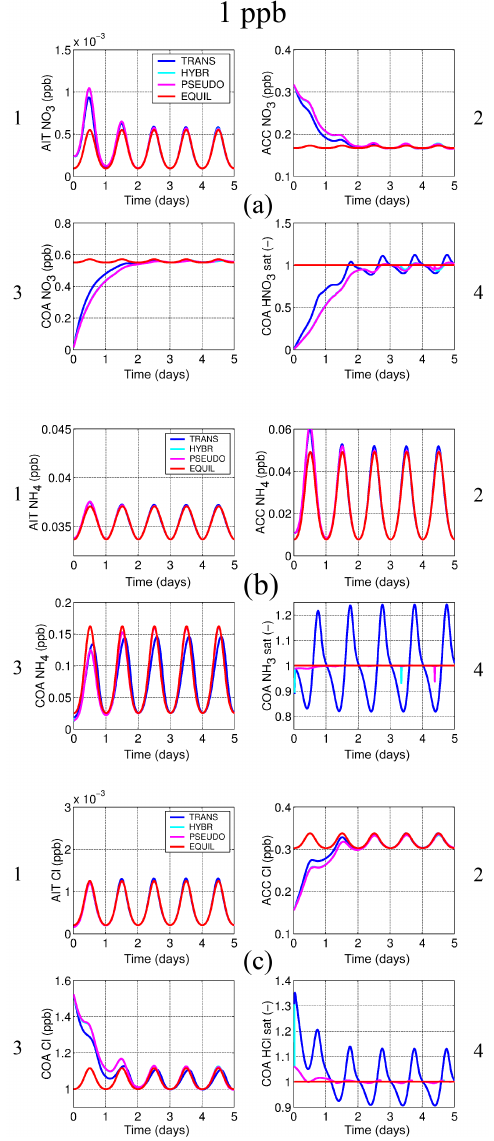
Figure 9. Size-resolved box-modelling evaluation of HyDiS-1.0 with H 2 SO 4 / sea salt aerosol and initial mixing ratios of HNO 3 (g), NH 3 (g) and HCl(g) of 1ppb (series 2, see text). The solver is run in the fully dynamic (TRANS), hybrid dynamic and equilibrium (HYBR), equilibrium with pseudo-dynamic correction (PSEUDO), and full equilibrium configurations. Atmospheric volume mixing ratios of nitrate (a) , ammonium (b) , and chloride (c) in the aque- ous phase as a function of time for the Aitken (1) mode (H 2 SO 4 ) , and the accumulation (2) and the coarse (3) mode (sea salt), respec- tively. For the coarse mode, the degree of saturation (4) to nitric acid, ammonia, and hydrochloric acid is also shown. Note that due to sea salt, total chloride is larger than 1ppb. A diurnal tempera- ture cycle of T = 298 . 15 ± 5K is imposed. Note that HYBR is not distinguishable from PSEUDO due to almost similar